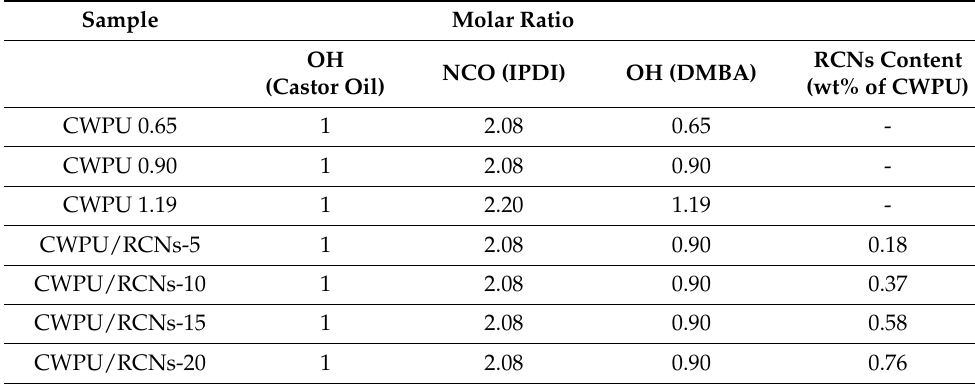
Table 1. Compositions of CWPU and CWPU/RCNs